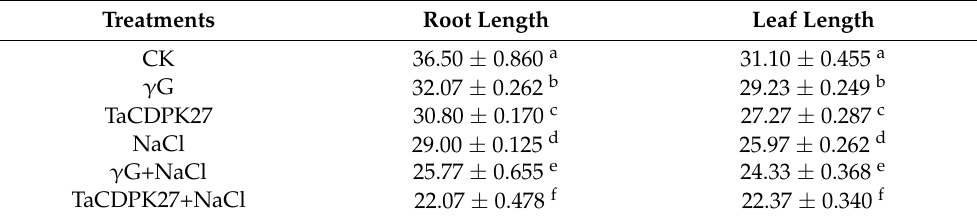
Figure 6. The effect of silencing TaCDPK27 on the cell death in leaves of wheat seedlings under NaCl stress. ( A ) Relative transcript levels of TaCDPK27 in leaves of BSMV-inoculated wheat seedlings. Standard deviations are shown ( n > 3, ± SD, p < 0.05). CK was from wild-type wheat seedlings, γ G was from BSMV-VIGS-GFP-inoculated wheat seedlings, TaCDPK27 was from BSMV-VIGS-TaCDPK27- inoculated wheat seedlings, and arabic numbers indicate individual TaCDPK27 -silenced seedling. The data with different letters (a & b) in same column show significant difference ( p < 0.05). ( B ) The effect of TaCDPK27 silencing on growth of wheat seedlings under NaCl treatment. ( C ) Evans blue staining results. Table 1. The effect of silencing TaCDPK27 on growth of wheat seedlings under NaCl